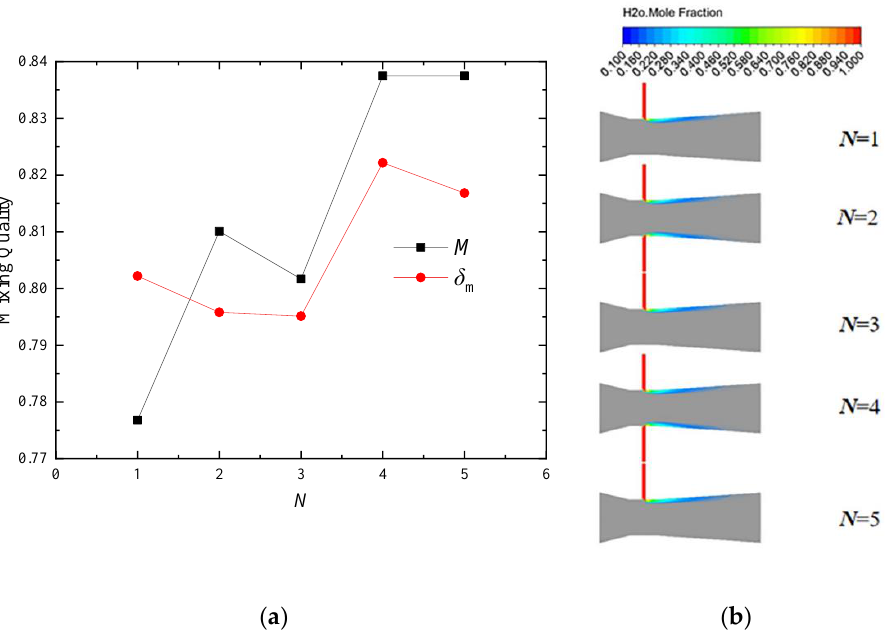
Figure 17. The effects of passive jetting tube number on ( a ) M and ( b ) concentration distribution of